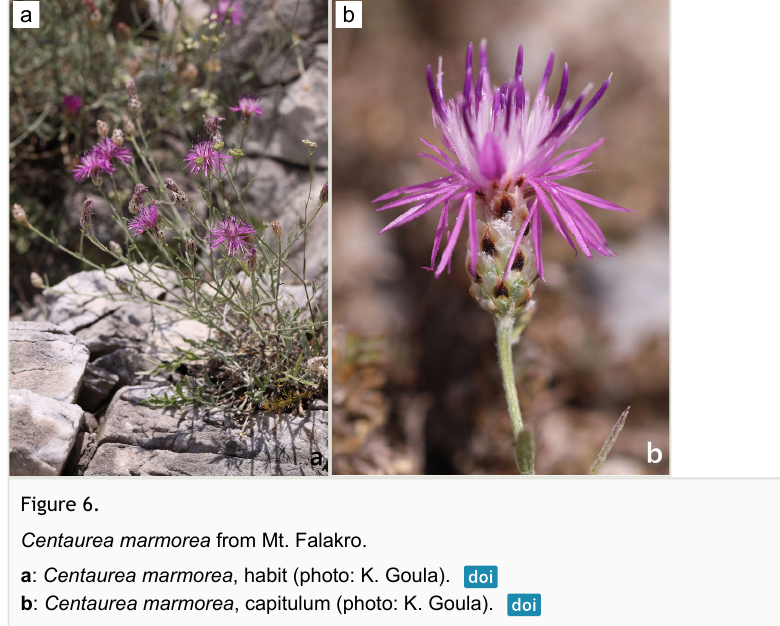
Figure 6. Centaurea marmorea from Mt. Falakro.